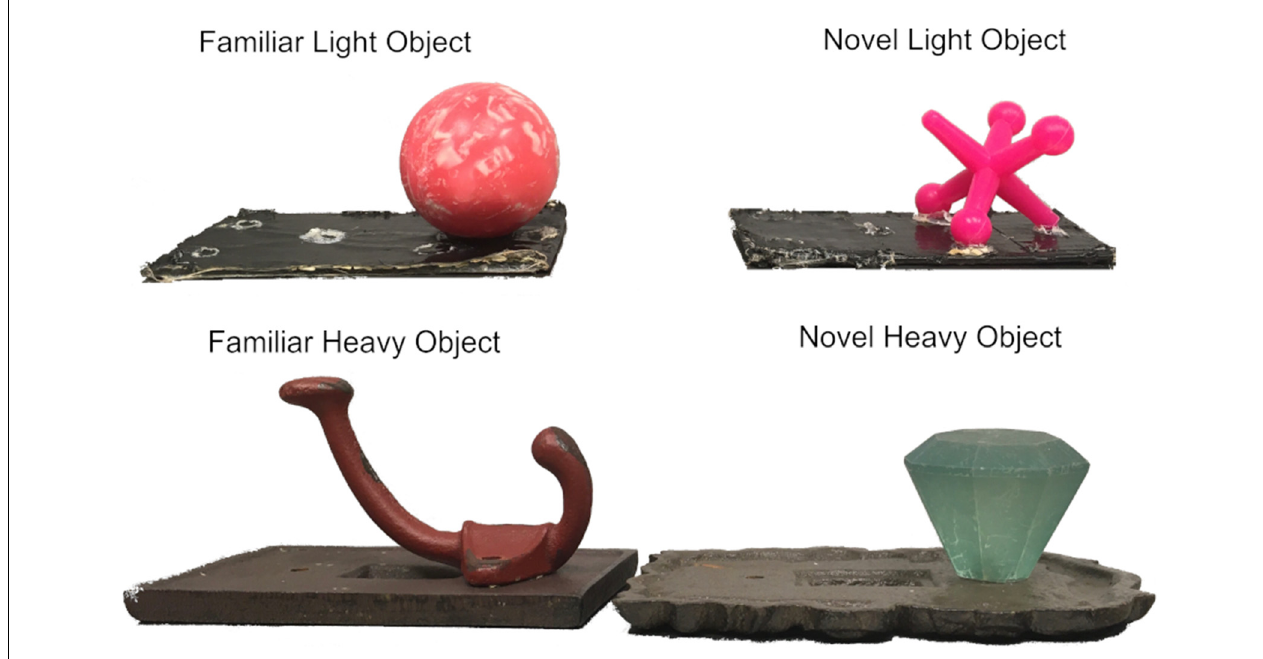
FIGURE 2 | Experiment 1 used light objects, experiment 2 used heavy objects. Light objects measured approximately 8 cm long × 4 cm wide × 3 cm high and weighed 7–30 g. Heavy objects measured approximately 13 cm long × 9.5 cm wide × 5 cm high and weighed 376–427 g. Familiar and novel objects were